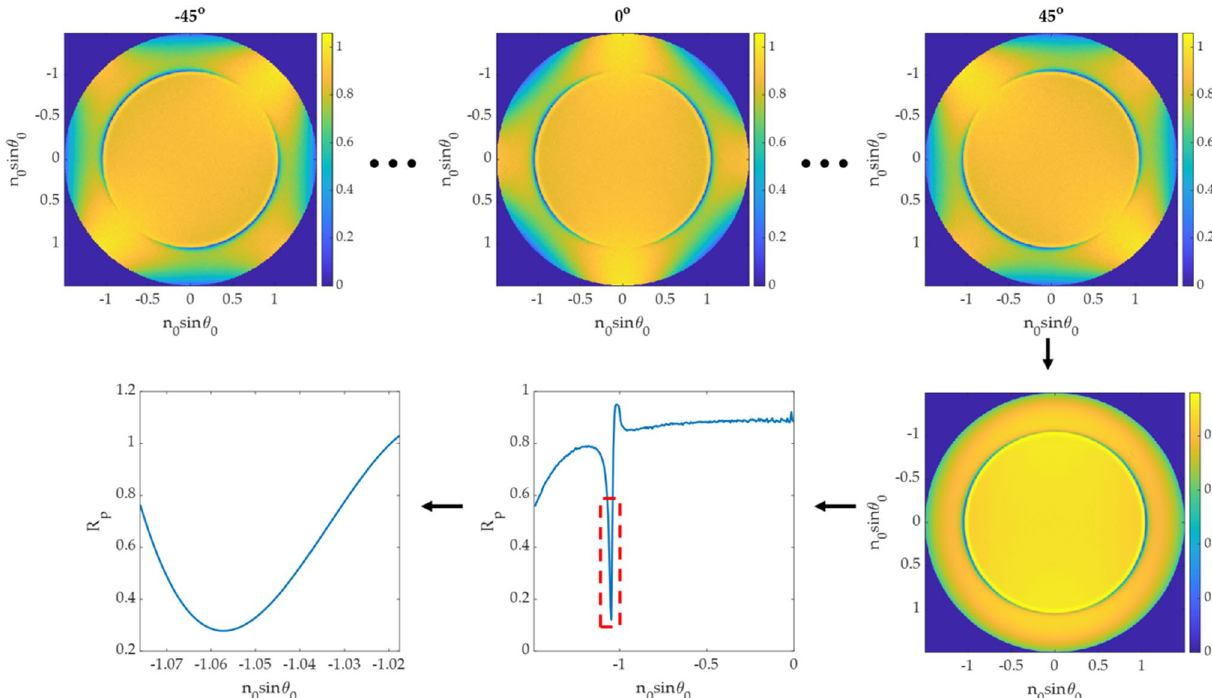
Figure 8. Steps in SPR measurement for azimuthal angle